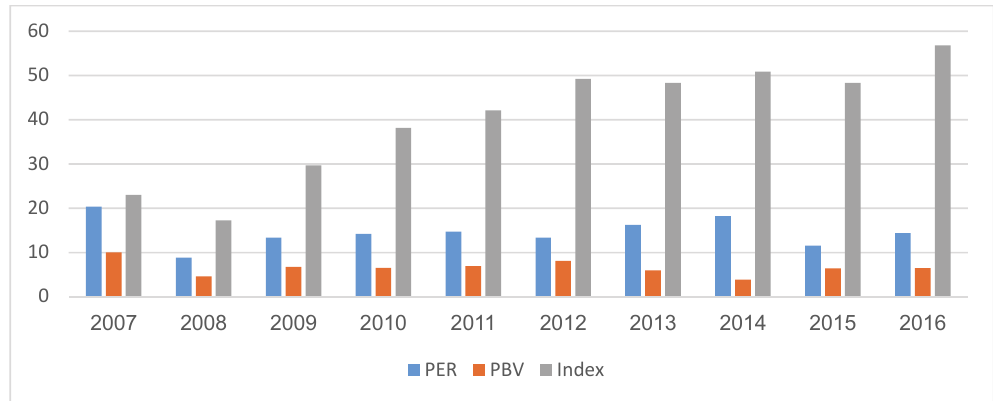
Fig. 1. Accounting Data and Indonesian Stock